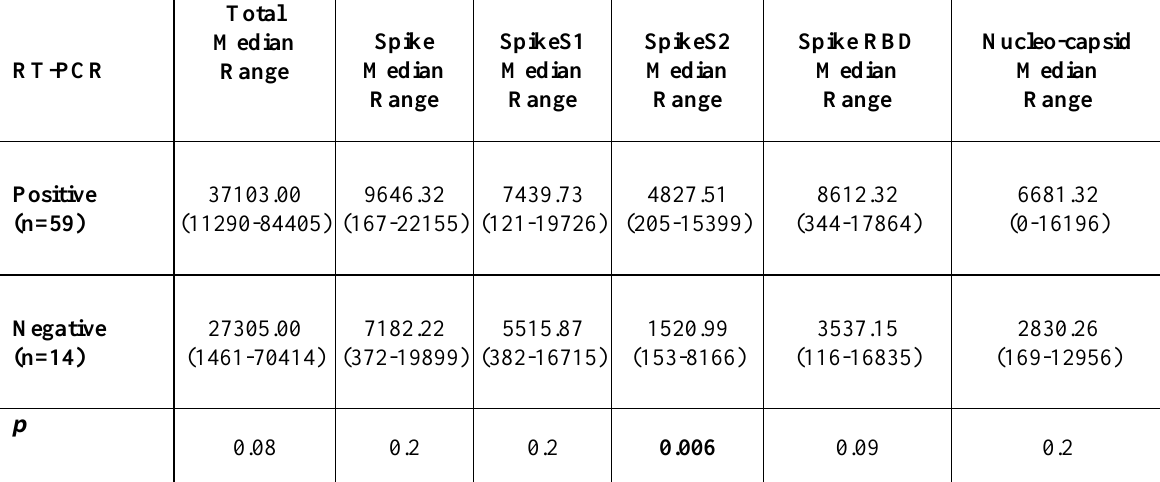
Table 3. Mean fluorescent intensities of antibodies against SARSCoV-2 by LABScreen COVID Plus Assay in relation to RT-PCR results.